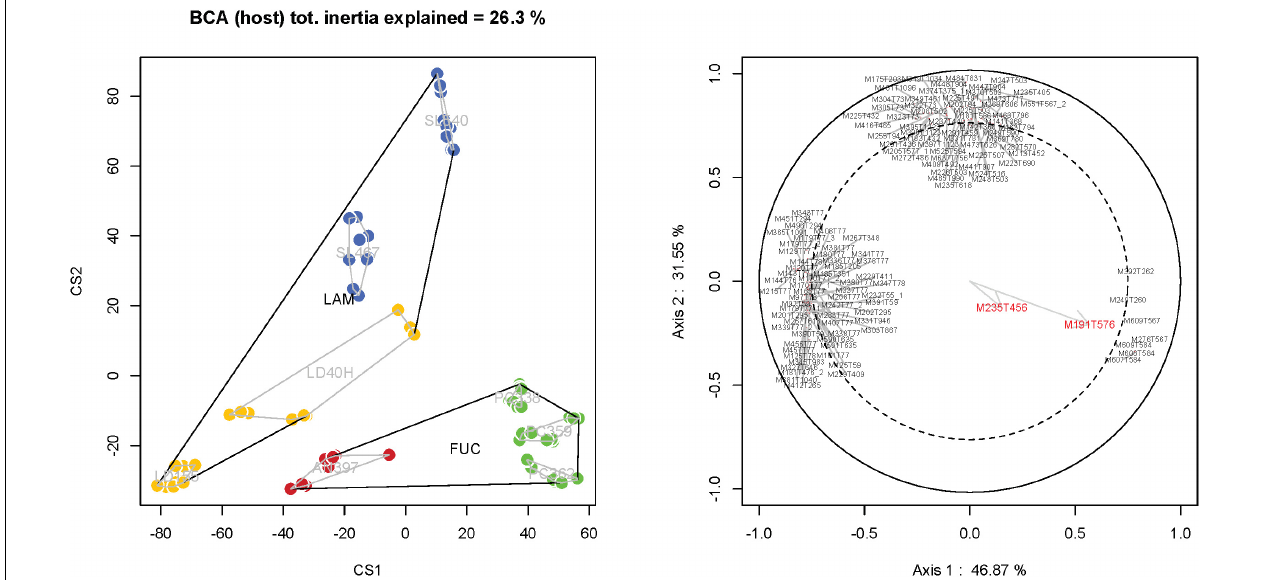
FIGURE 3 | Metabolome structuration of the P. salina strains according to the factor host (BCA) and variable importance in projection (VIP) indicating the importance of each m/z features in the discrimination between specific sample classes (correlation > 0.75) and the distribution of dendryphiellone A (feature M235T456) and dendryphiellone D